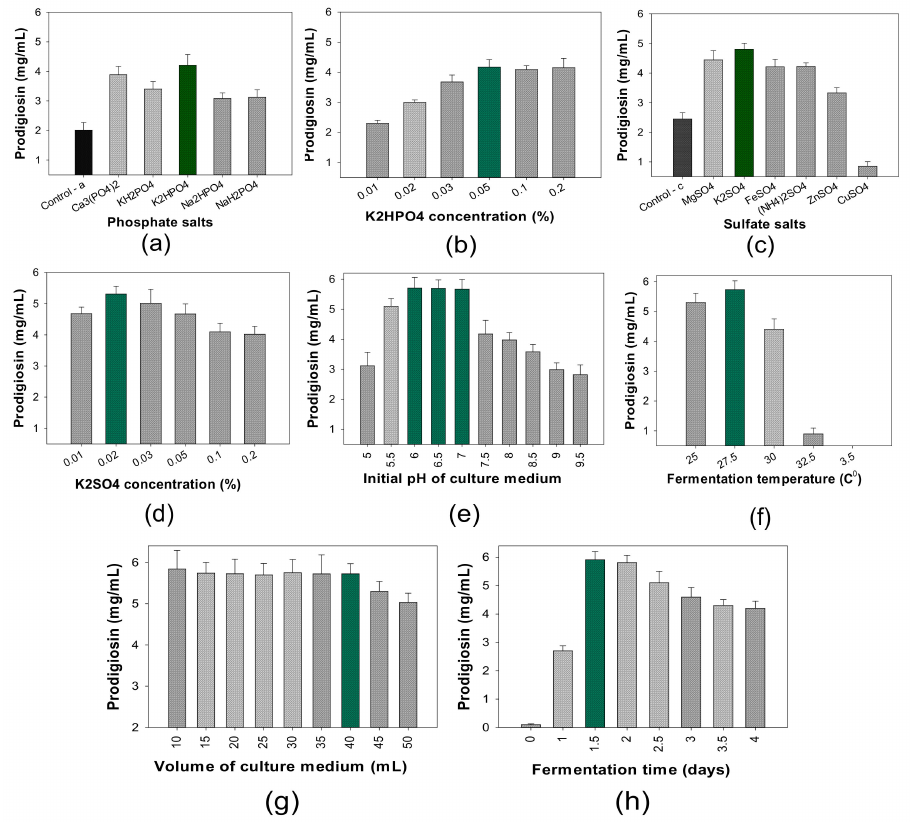
Figure 3. The influence of phosphate salt sources ( a ), KH 2 PO 4 concentration ( b ), sulfate salt sources ( c ), K 2 SO 4 concentration ( d ), pH of the liquid medium ( e ), temperature of fermentation ( f ), volume of the liquid medium ( g ), and time course for fermentation ( h ) on PG yield by S. marcescens TNU01 fermentation. The error bars in the figures are standard errors